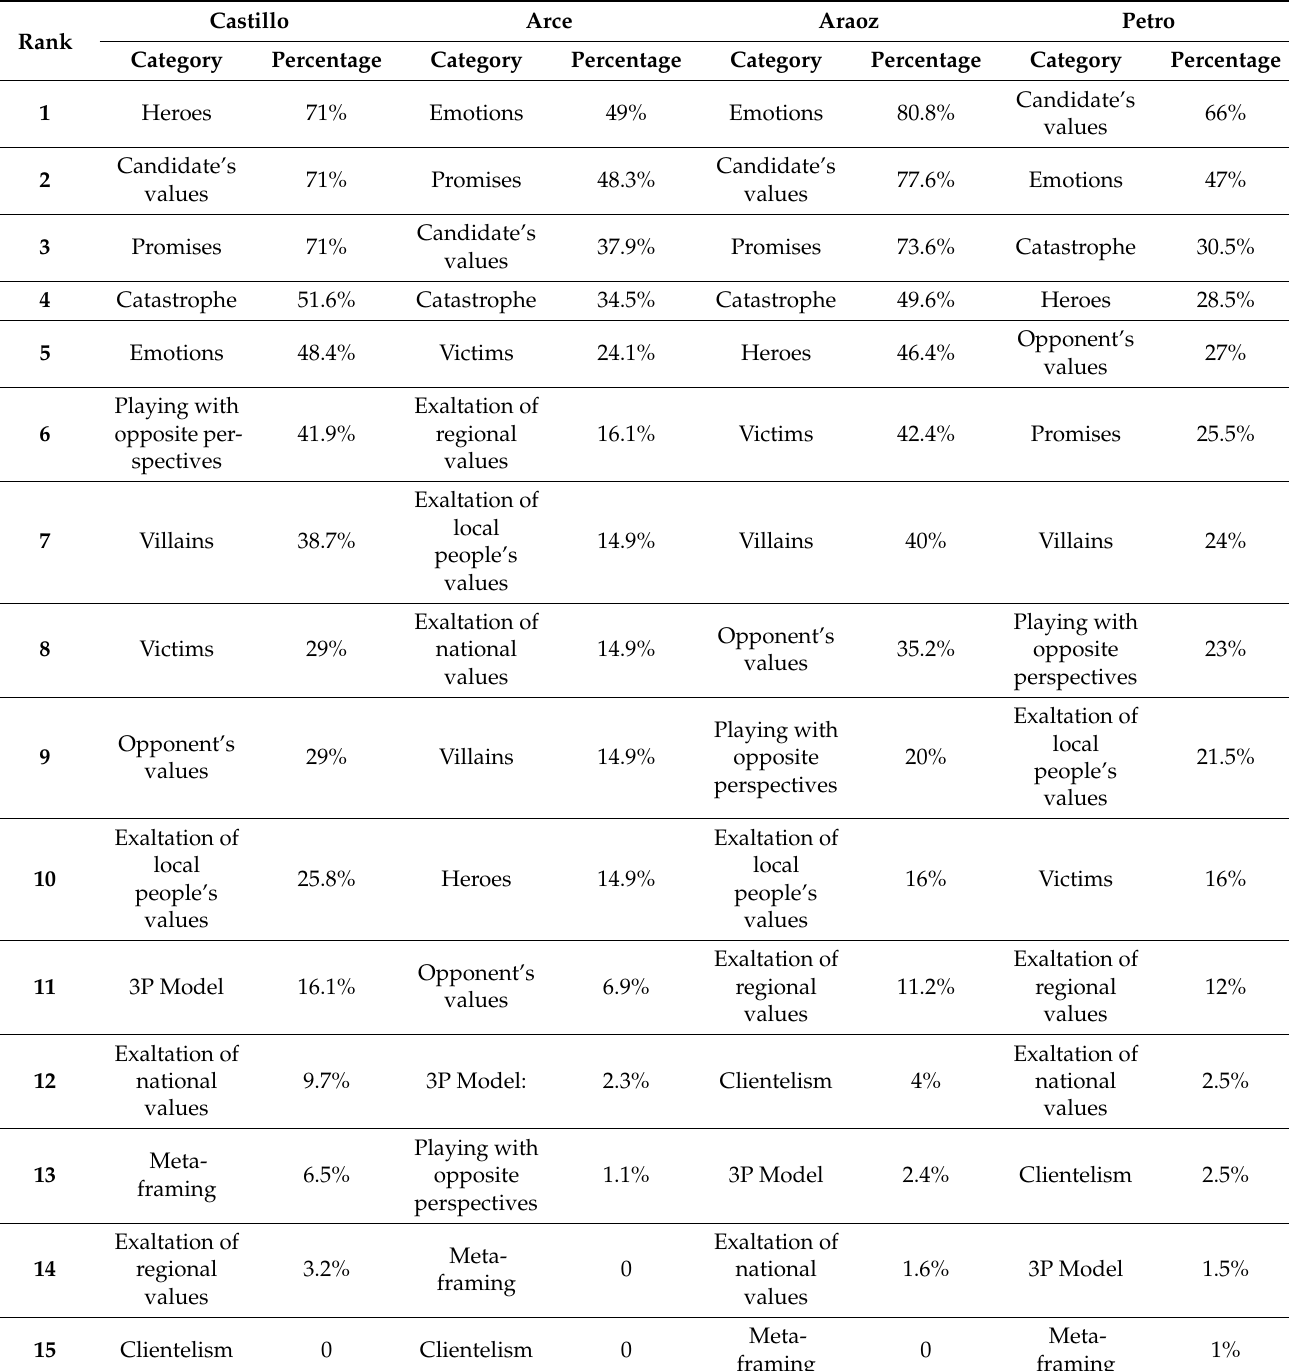
Table 4. Populist categories of left-wing